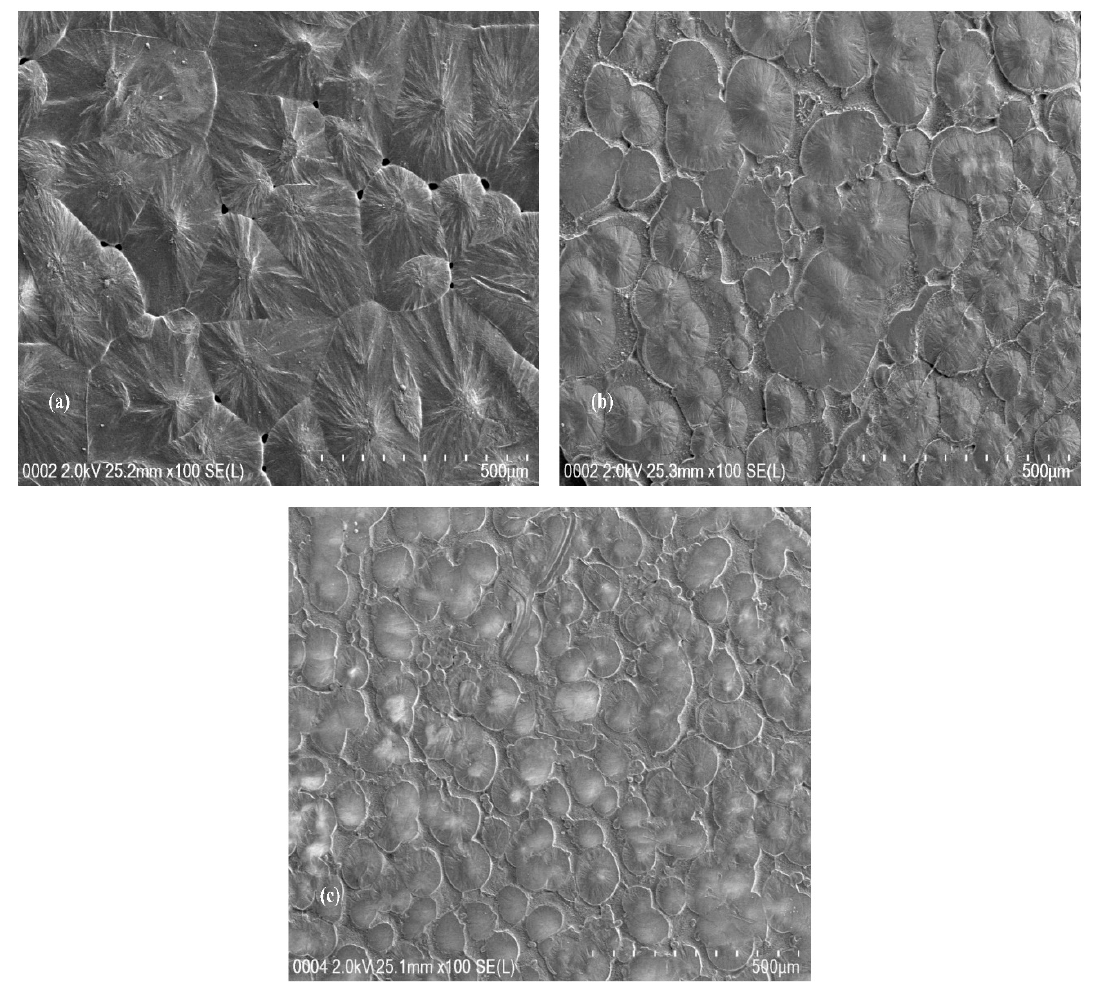
Figure 2. FESEM images of the ( a ) pure PEO, ( b ) PEO:CNDs, and ( c ) PEO:CNDs:Ag samples.